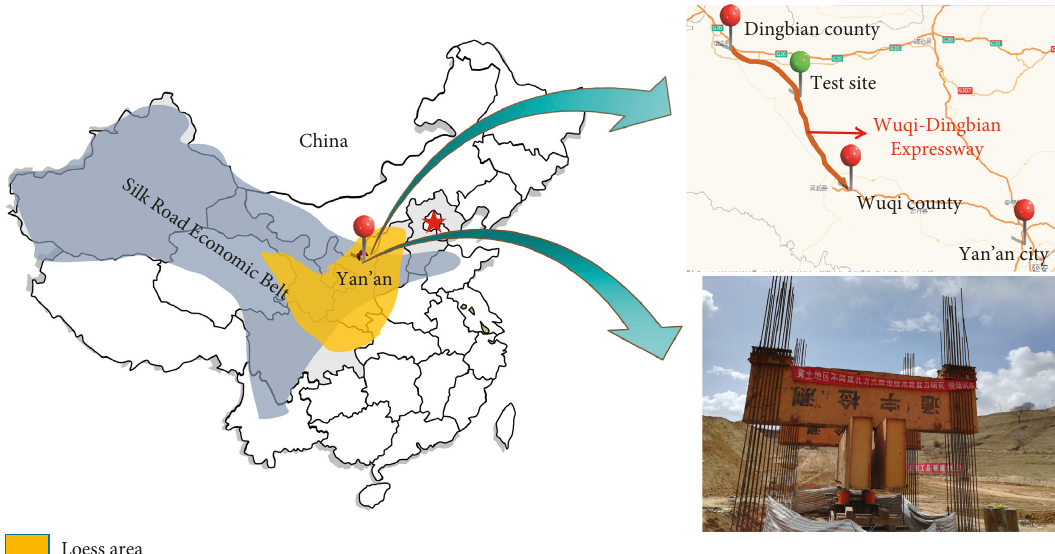
Figure 1: The location of the study area (map data © 2018 Baidu maps; loess area distribution © Baidu encyclopedia; the picture was taken by Zhijun